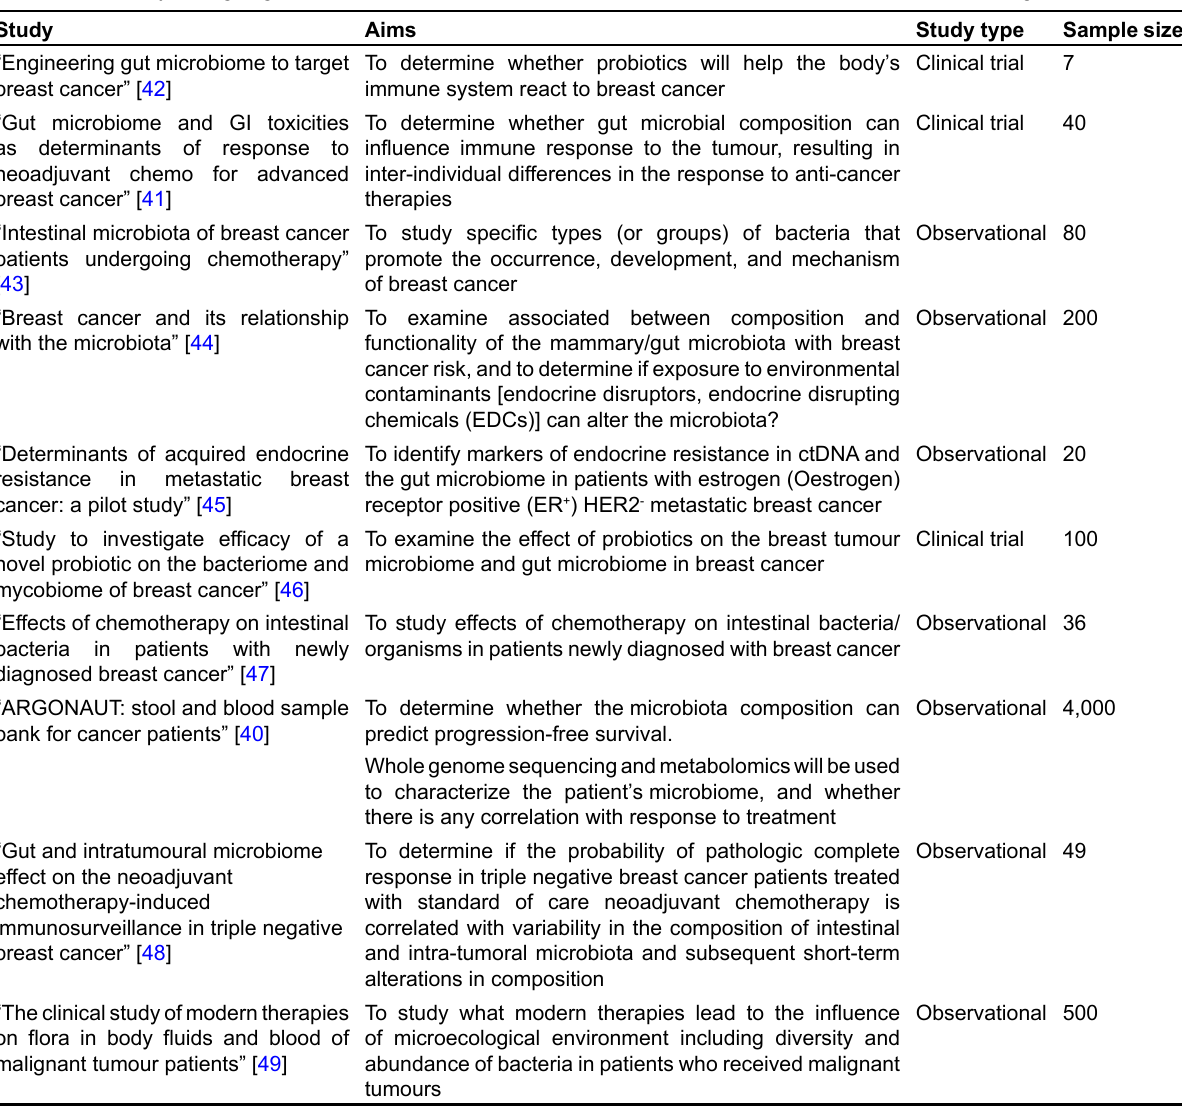
Table 1. Summary of ongoing clinical trials and observational studies in breast cancer treatment in relation to gut microbiota Study